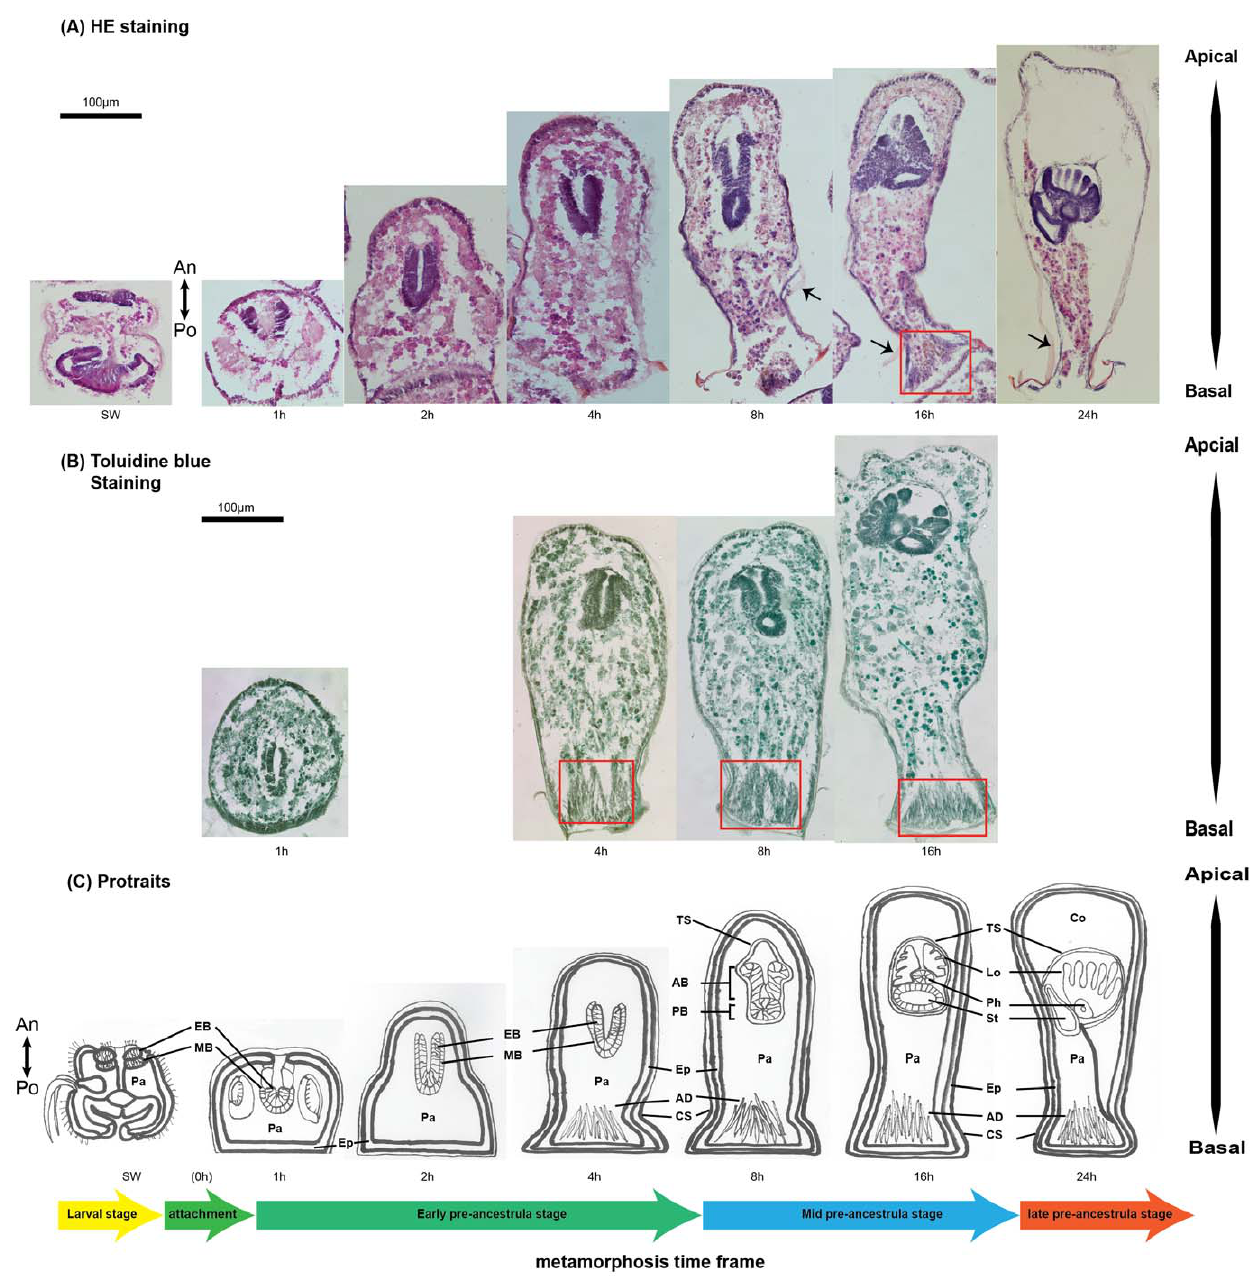
Figure 1. Histology of metamorphosis of Bugulaneritina . ( A ) HE-stained and ( B ) Toluidine-stained sections of different metamorphic stages of the bryozoan B. neritina . The red boxes show the interlocking fibrous cells of the basal adhesion disc. Arrows point at the calcified shell. Portraits in ( C ) were modified from [7] and according to the histology of each stage. A time line for metamorphosis was defined by the overall morphology of the pre-ancestrula stage and the anatomy of the blastemas (the presumptive polypide). Note that the anterior-posterior axis and the apical-basal axis were used to represent the primary body axis of swimming larvae and pre-ancestralae respectively. AB, apical blastemas; AD, adhesion disc; An: anterior; BB, basal blastema; Ep, epidermis; Co, coelom; CS, calcified shell; Lo, (presumptive) lophophore; MB, mesodermal blastema; PC, parenchyme cells; Ph, (presumptive) pharynx; Po: posterior; St, (presumptive) stomach; TS, (presumptive) tentacle sheath. doi:10.1371/journal.pone.0033323.g001 peaked in the early pre-ancestrula stage, decreased in late the pre- ancestrula stage and then increased in the ancestrula stage to the BnWnt6 . The results of BnWnt6 Whole mount in situ same level as in the early pre-ancestrula stage. The gene expression Hybridization (WISH) and a section of WISH are showed in levels of BnFz5/8 and BnFz4/9/10 were more stable, with less than Fig. 3. BnWnt6 was expressed in the dorsal side of the wall region of the internal sac. During the attachment process, BnWnt6- a single-fold fluctuation, during the full metamorphosis. BnGSK3 b expressing cells become part of the apical epidermis peripheral to was substantially down-regulated during the two pre-ancestrula the central axis. At 2 h post-attachment, BnWnt6 expression was stages but was up-regulated during the ancestrula stage.